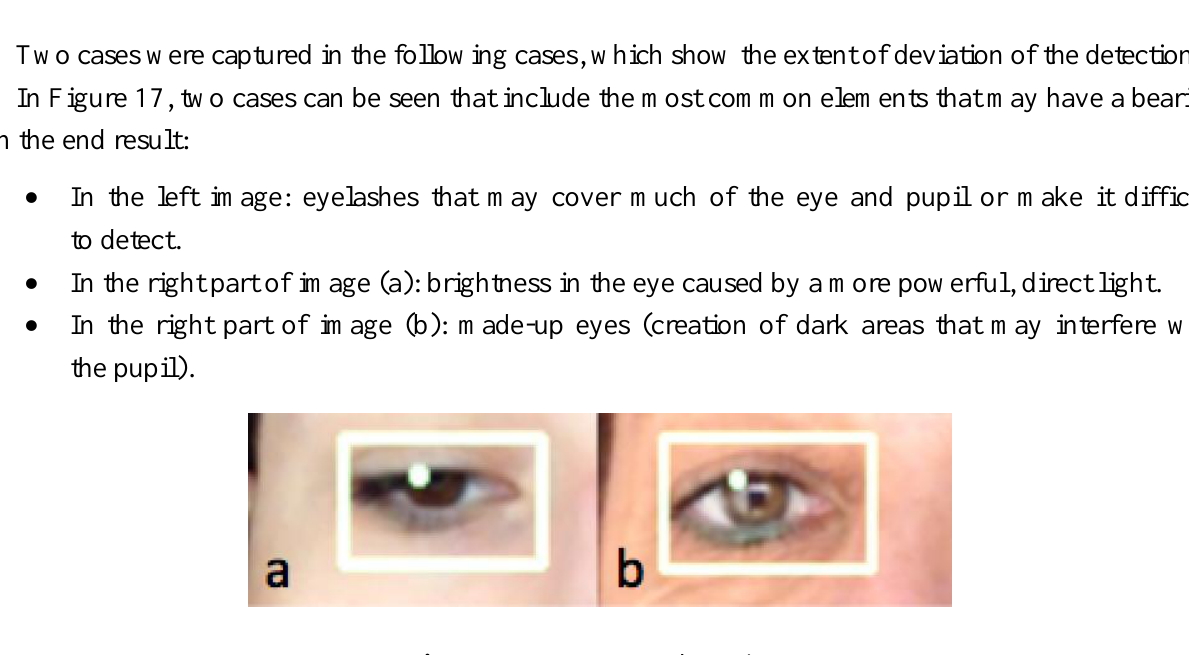
Figure 16. User with glasses 2.